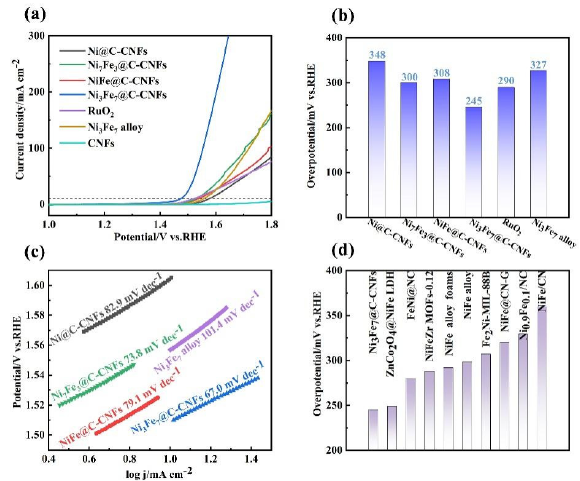
Figure 5. ( a ) LSV polarization curves after iR correction; ( b ) The overpotentials obtained from po- larization curves at the current density 10 mA cm − 2 ; ( c ) The corresponding Tafel plots; ( d ) Compar- ison of overpotentials at 10 mA cm − 2 of Ni 3 Fe 7 @C-CNFs with reported literatures.